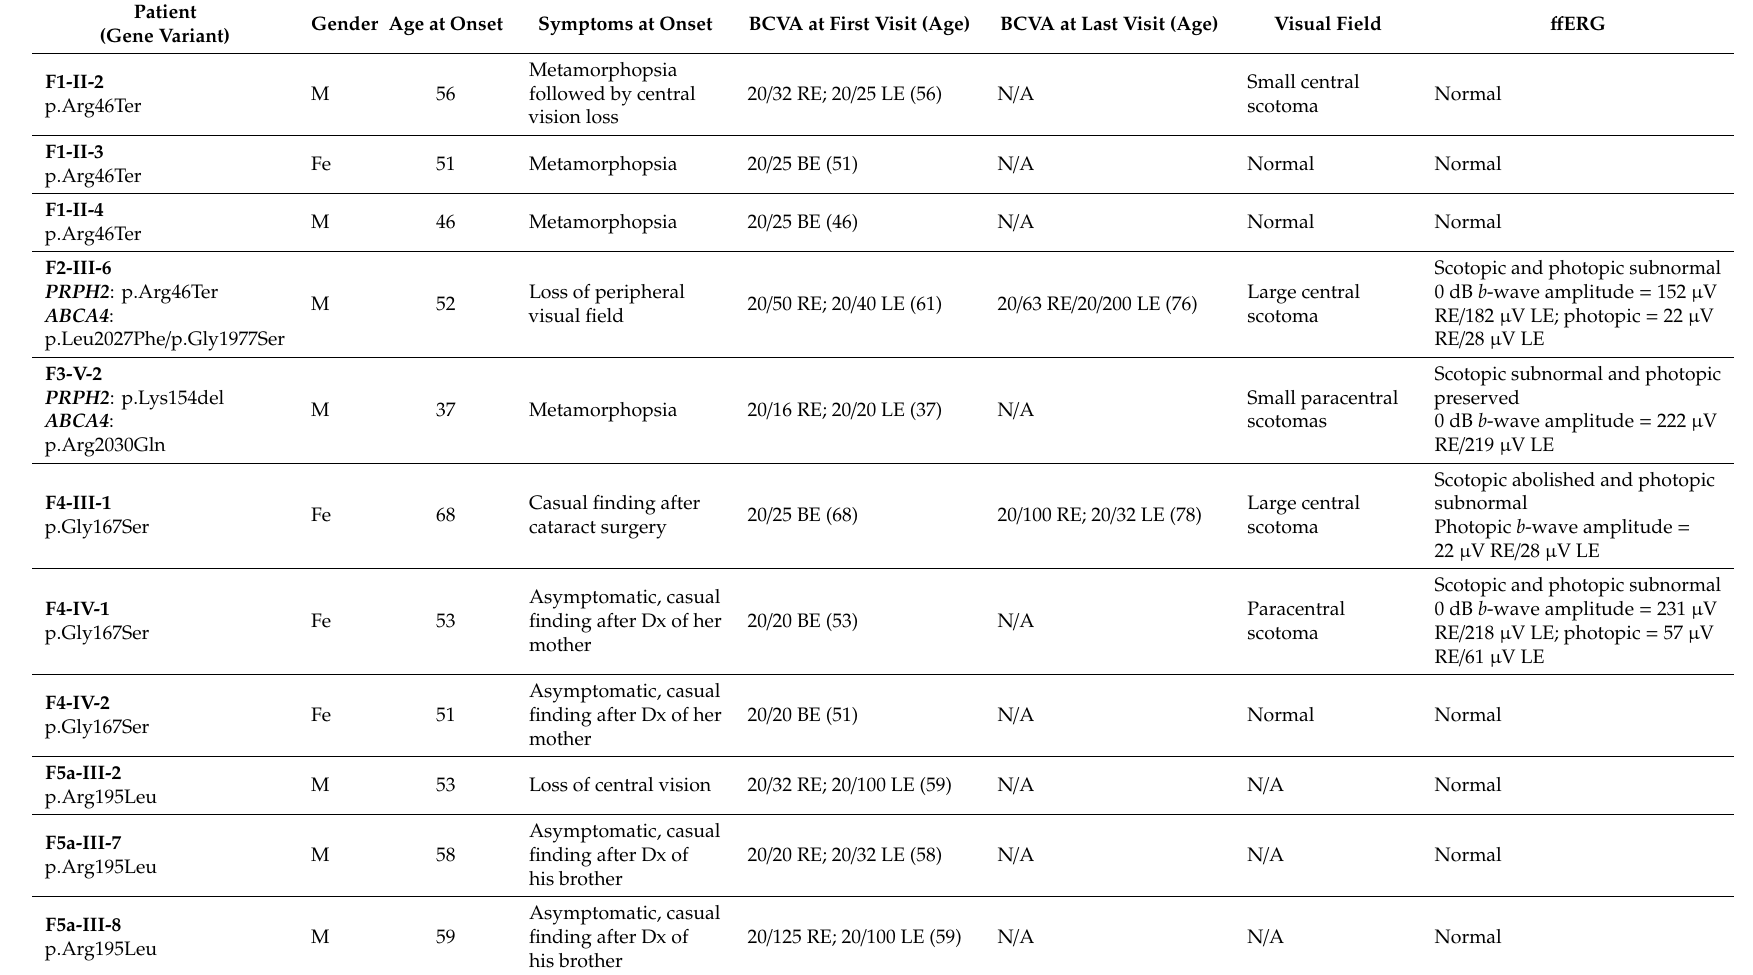
Table 1. Functional characteristics of patients’ clinical